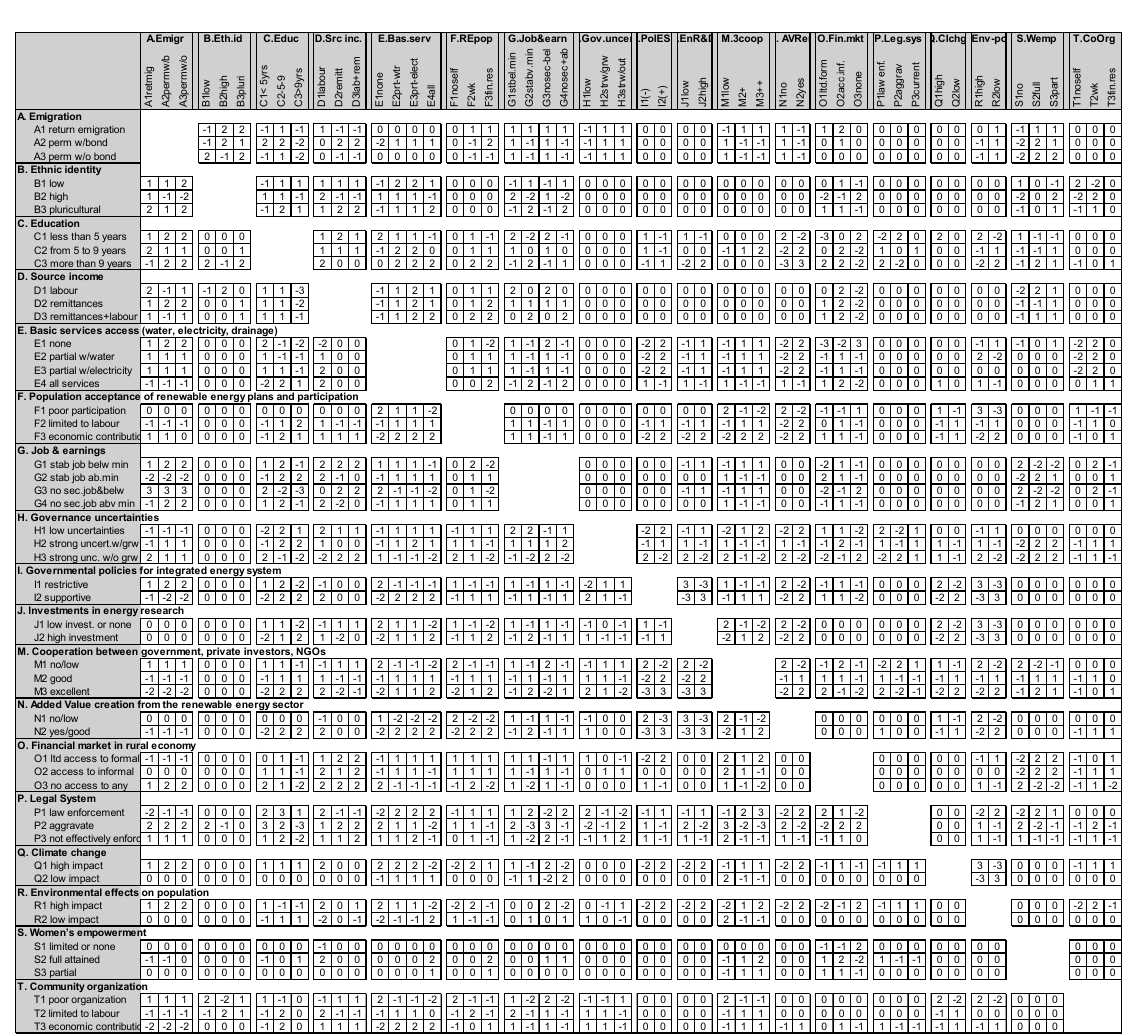
Figure A1. Cross-Impact Matrix (CIM).